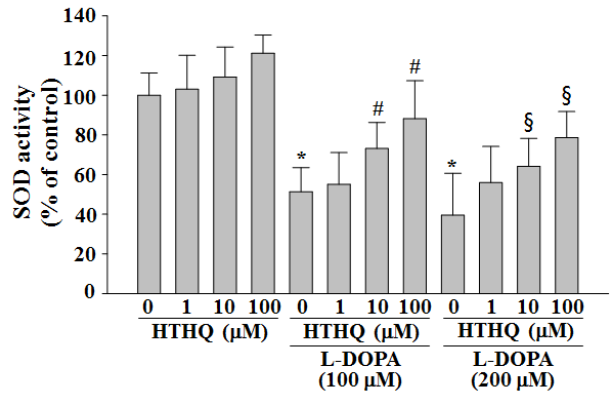
post-hoc Tukey’s test).